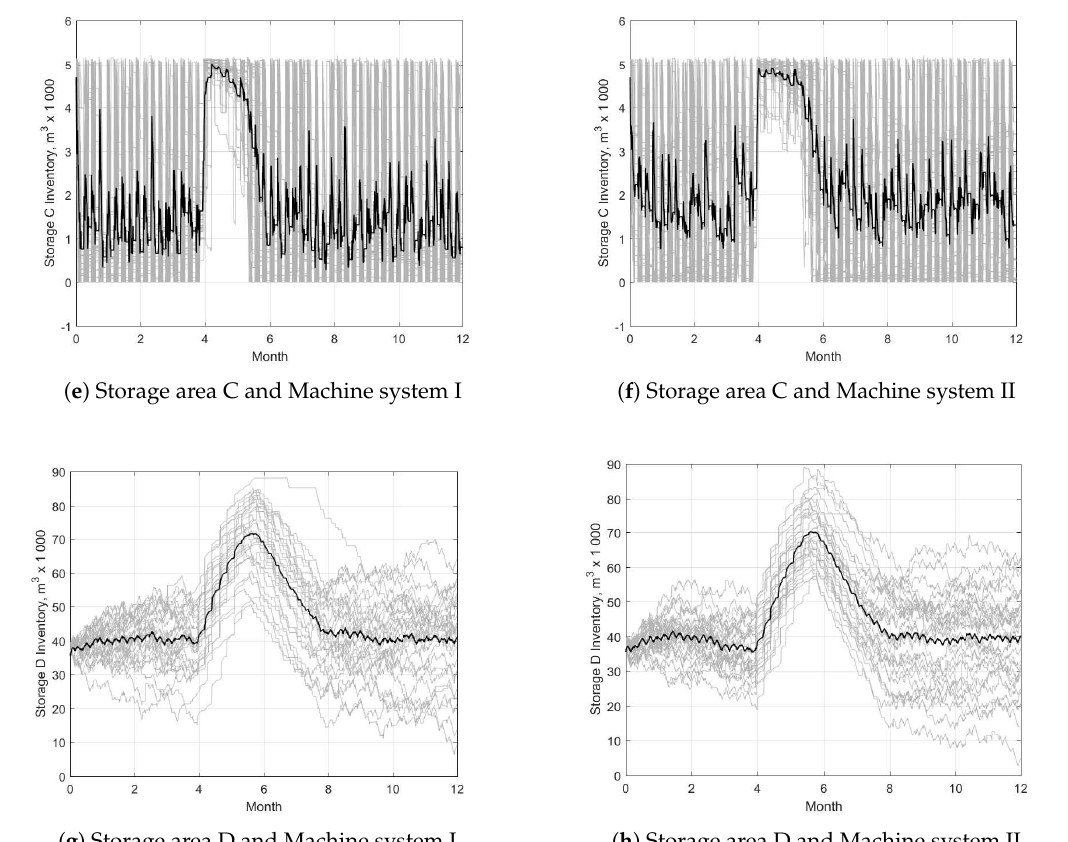
Figure 5. Average of 30 yearly simulation results (black line) and individual results of 30 yearly simulations (grey lines) showing inventory level fluctuation at storage areas A, B, C, and D under Strategy II using Machine Systems I (left side) and II (right side) (S2 M1 and